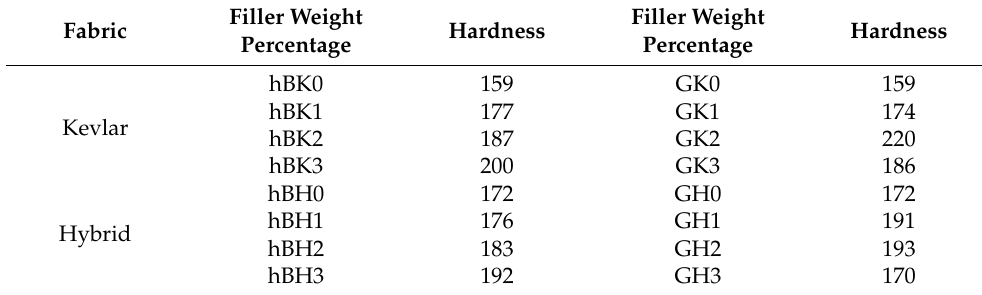
Table 8. Impact strength values of hBN-filled graphene composites.